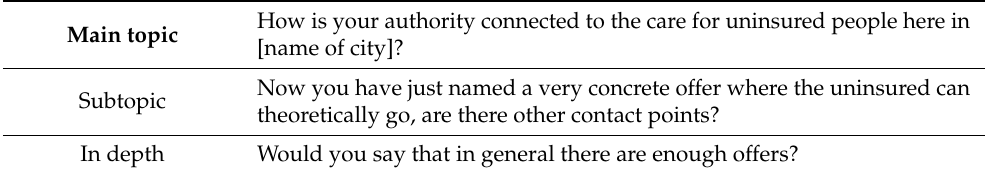
Table 1. Exemplary application of the interview guide from the interview with expert P6. See Figure 1 and Supplementary File S1 (German original version) for the full interview